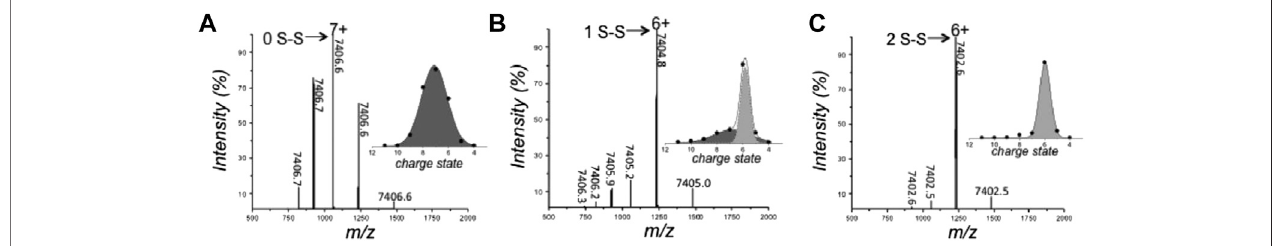
FIGURE 2 | Analysis of the conformation and oxidative state of hCox17 species by native MS. nMS spectra of the hCox17 (10 μ M) refolding reaction at pH 6.7. hCox17 species are labeled according to their charge state and number of disul fi de bridges. Insets show the Gaussian fi ts to the observed CSDs. (A) Fully reduced hCox17 in the presence of 50 mM DTT. (B) Partially oxidized hCox17, 8 h after the removal of DTT. (C) Completely oxidized hCox17, 17 h after the removal of DTT. Figure adapted from (Fraga et al.,